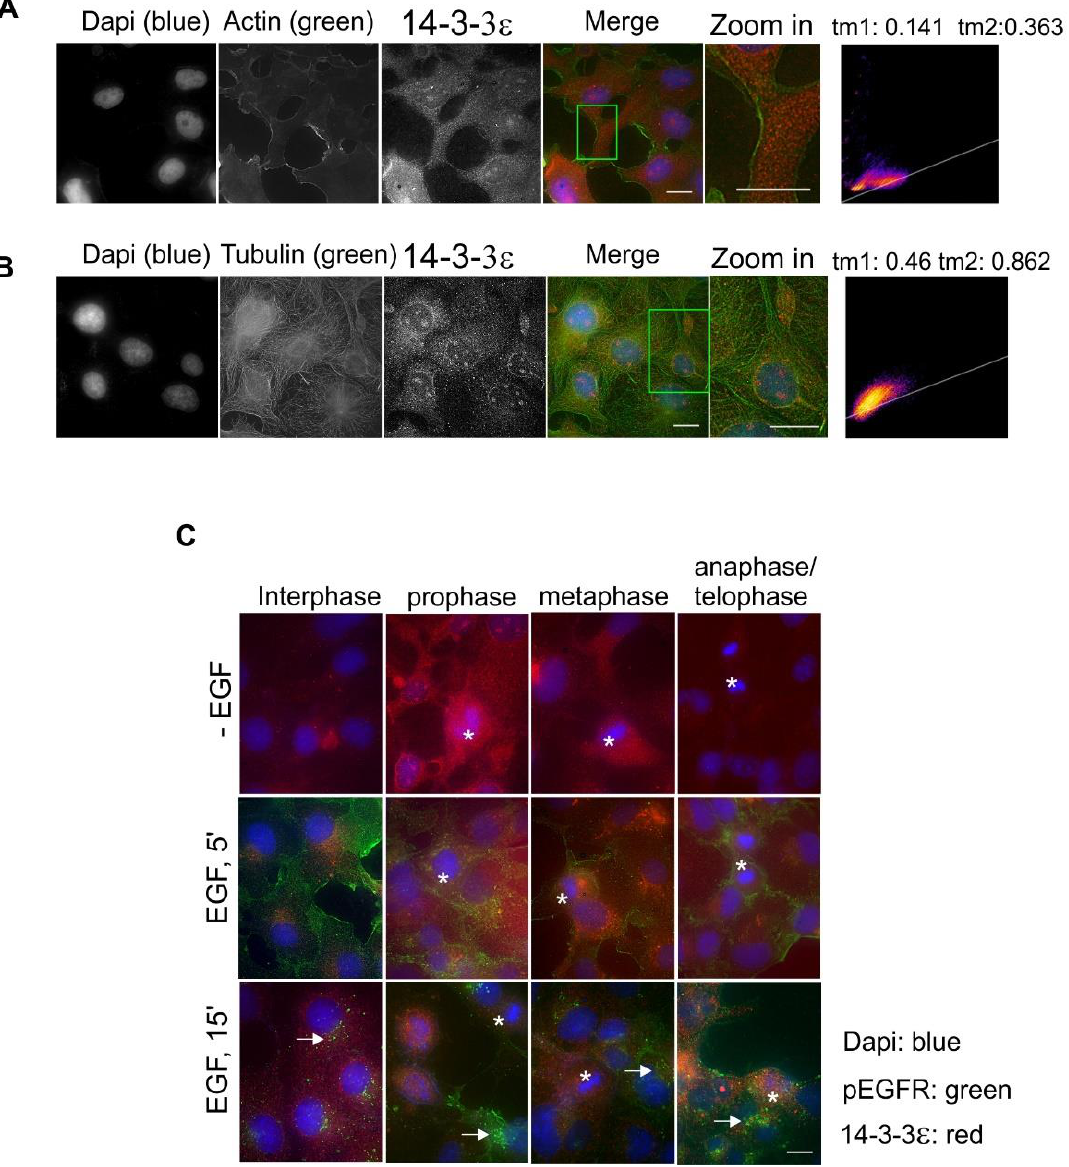
Figure 5. Subcellular localization of 14-3-3ε in Cos-7 cells by double indirect immunofluorescence. ( A ) Co-localization of 14-3-3ε (red) and actin (green); ( B ) co-localization of 14-3-3ε (red) and tubulin (green). For (A,B), the zoomed-in areas were used to calculate Mander’s coefficients. ( C ) Subcellular localization of 14-3-3ε during the cell cycle and in response to EGF. With or without EGF stimulation, 14-3-3ε (red) and pEGFR (green) were revealed by double indirect immunofluorescence. Mitotic cells are labeled by * and endosomes are marked by arrows. Scale bar = 10 μm.